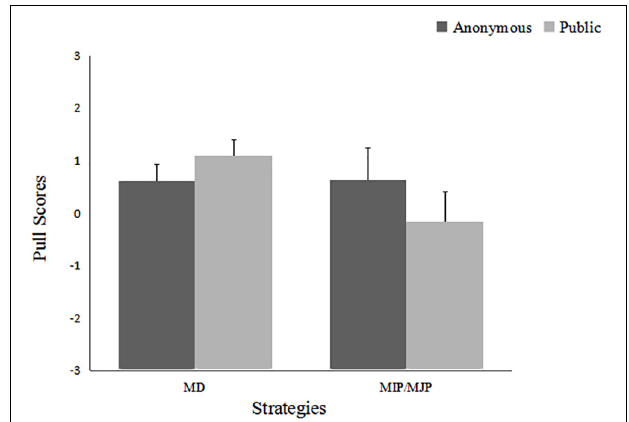
FIGURE 3 | Pull scores as a function of results presentation and strategies: Experiment